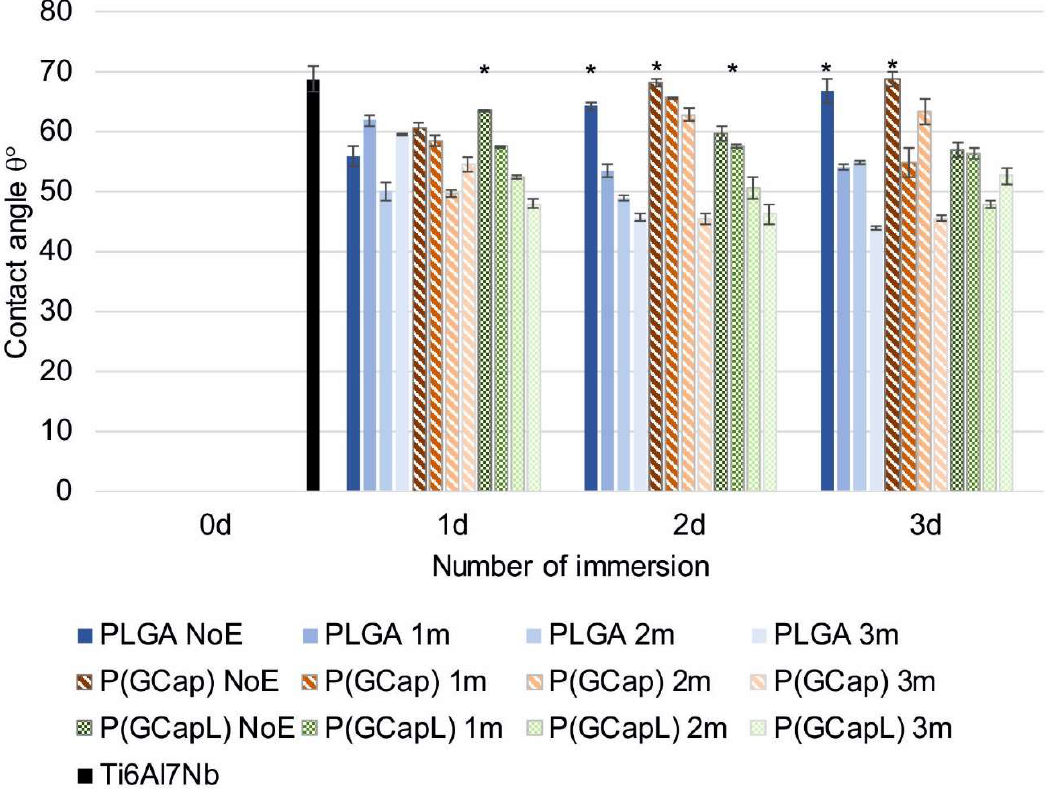
Figure 2. Wettability test results for samples after different numbers of dips and times of exposition to Ringer’s solution for the PLGA, P(GCap), and P(GCapL) coatings ( * p < 0.05 versus the control group).